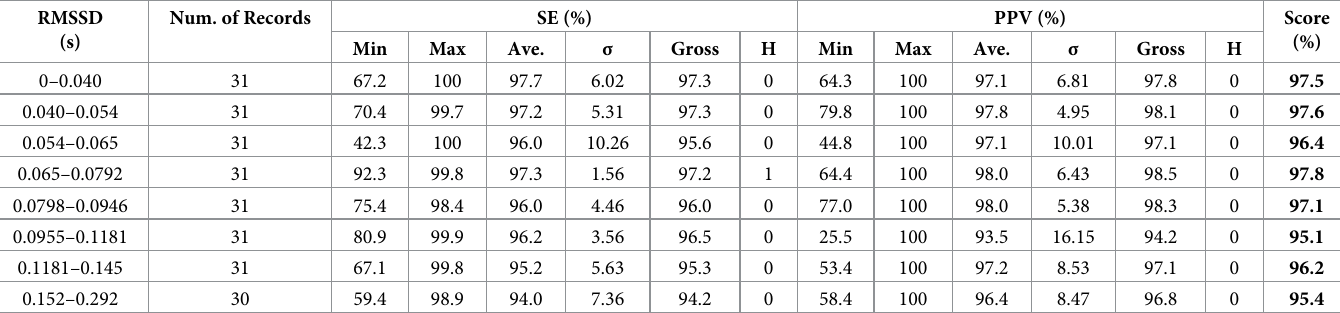
Table 4. Performance scores of MGH/MF waveform database grouped by RMSSD. RMSSD Num. of Records SE (%) PPV (%) Score (s)